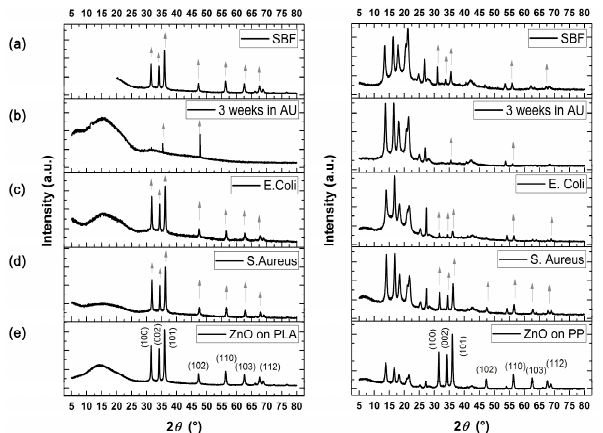
Figure 12. XRD pattern of samples ZnO@PLA and ZnO@PP: ( a ) after soaking in simulated body fluid solution for 14 days; ( b ) after immersion in artificial urine for 21 days; ( c , d ) at the end of the antimicrobial tests. XRD pattern of ZnO@PP and ZnO@PLA samples are also shown as reference in panel ( e ). Arrows indicate reflections coming from wurtzite ZnO phase.